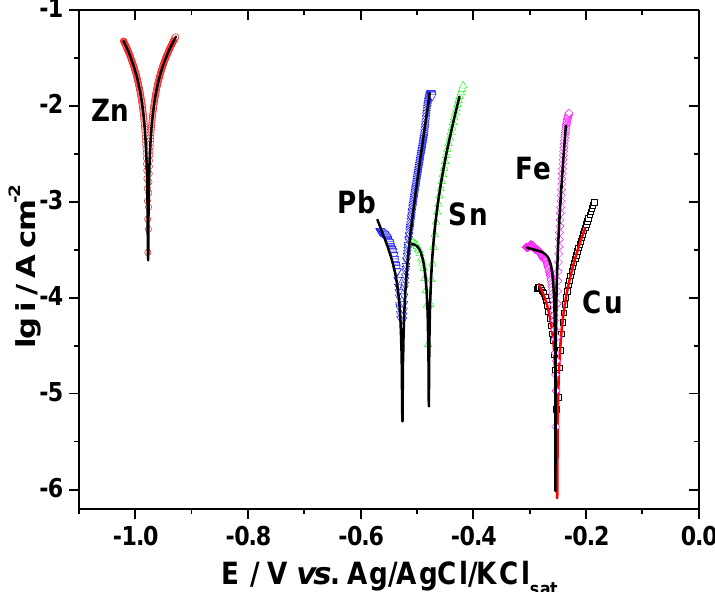
Figure 2. Polarization curves of various metals in Sol. C. Symbols, experimental data; lines, calculated data by Stern–Geary.